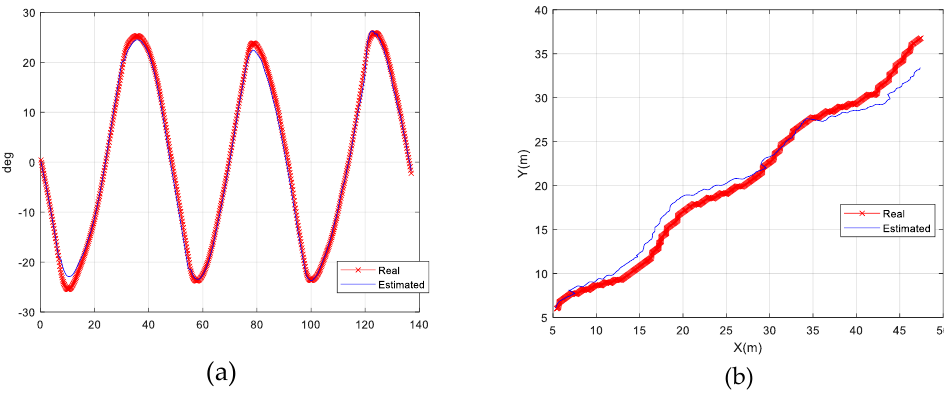
Figure 6. Trial #3 — Zig-Zag 20 – 20. ( a ) Heading angle estimation; ( b ) trajectory prediction.